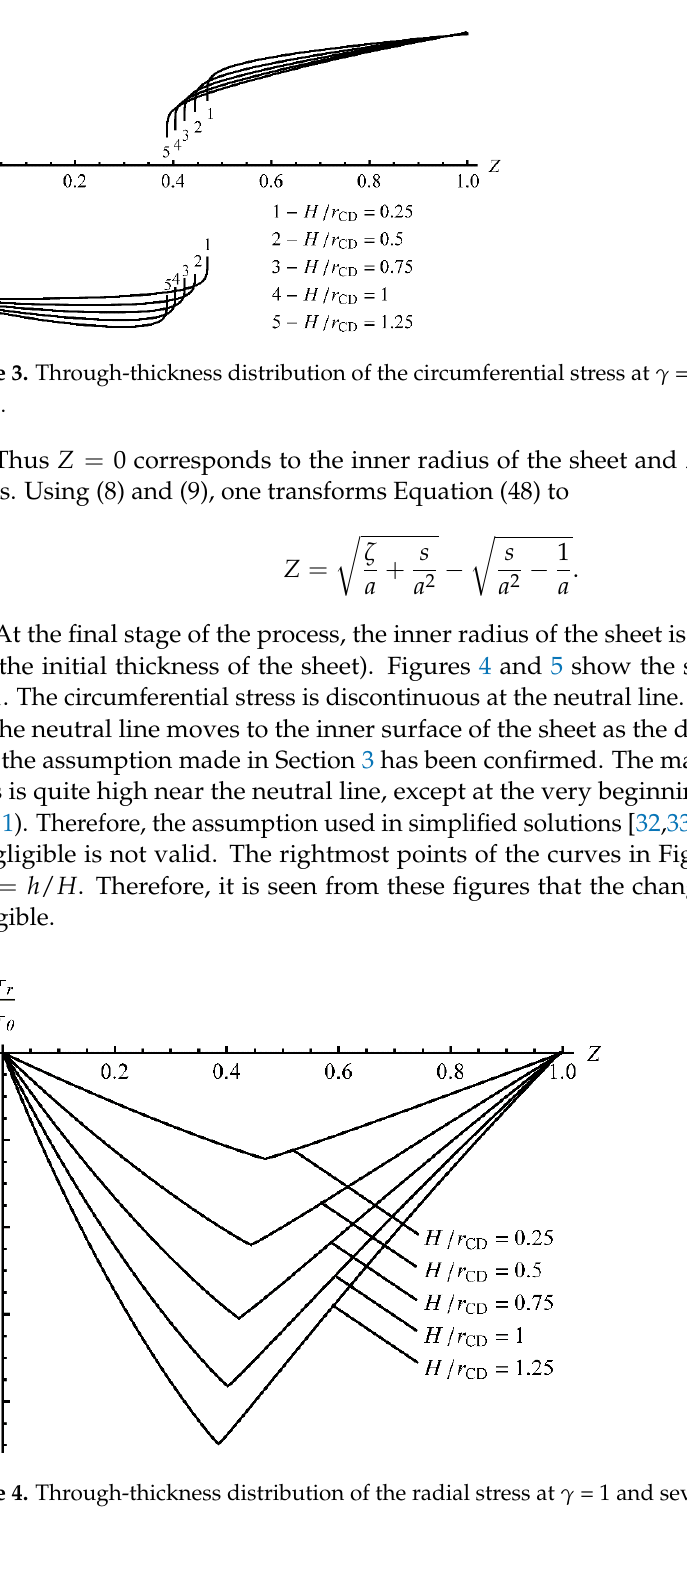
Figure 5. Through ‐ thickness distribution of the circumferential stress at γ = 1 and several process stages. Figure 6. Variation of the dimensionless bending moment as the deformation proceeds at several values of γ . The broken line corresponds to the rate ‐ independent material.